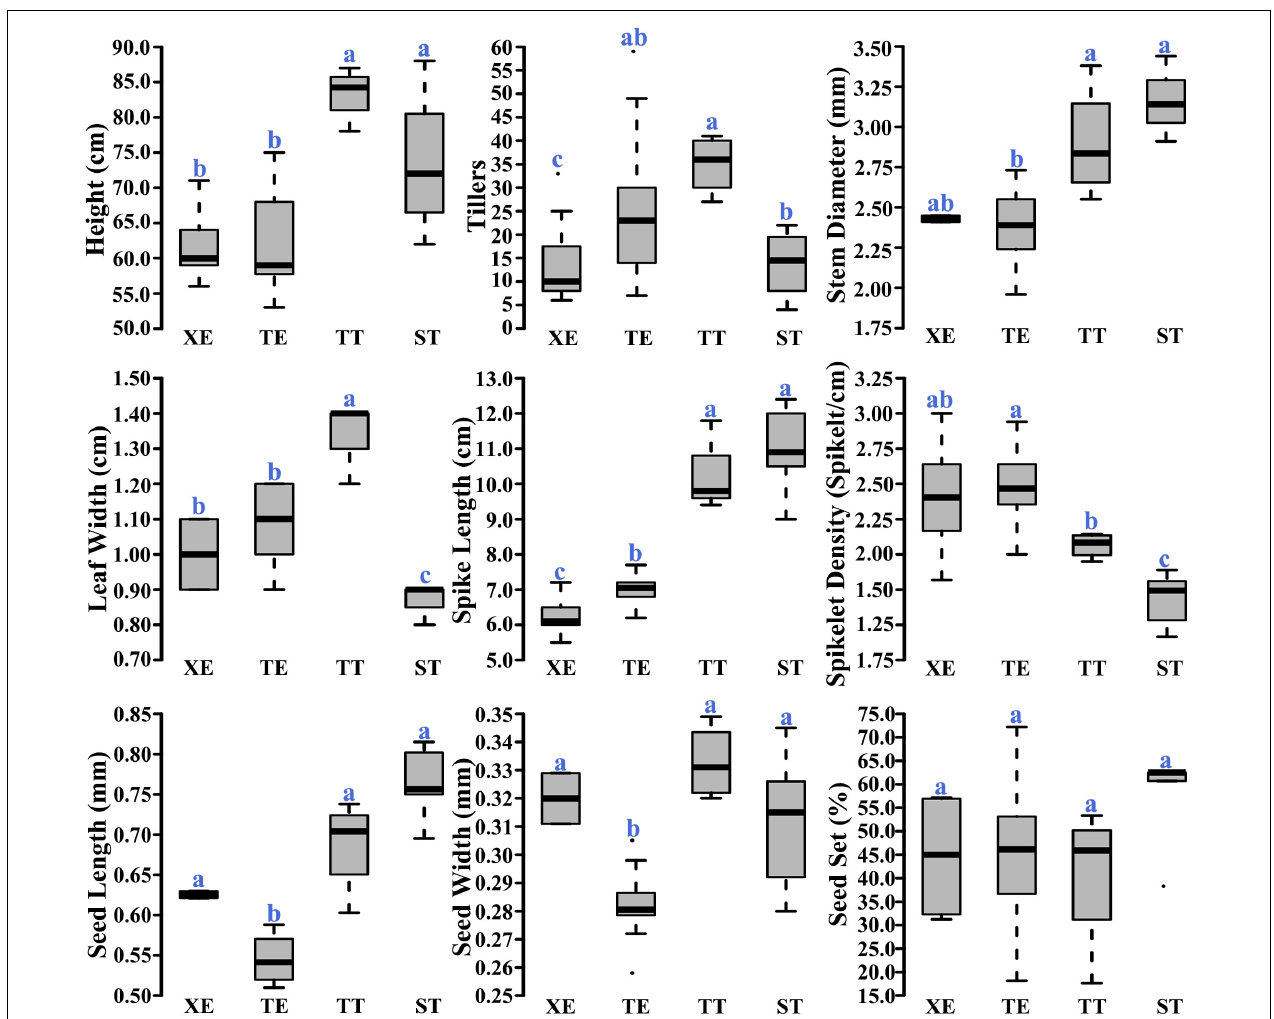
FIGURE 5 | Comparisons of the nine phenotypic traits among the four immediate progeny swarms of the pentaploid wheat lines. Letters above the boxplots denote statistical significance of the pairwise comparisons (Wilcox. test, P -value <